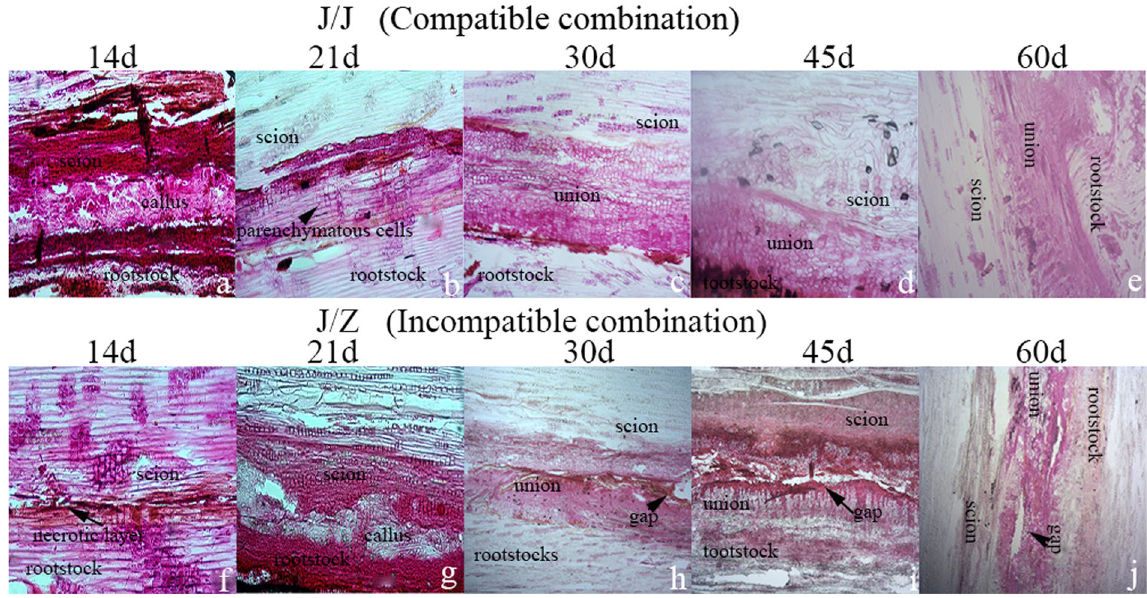
Figure 2. Anatomical analysis of the litchi compatible graft J/J ( a – e ) and incompatible graft J/Z ( f – j ) at 14 d, 21 d, 30 d, 45 d and 60 d after grafting.